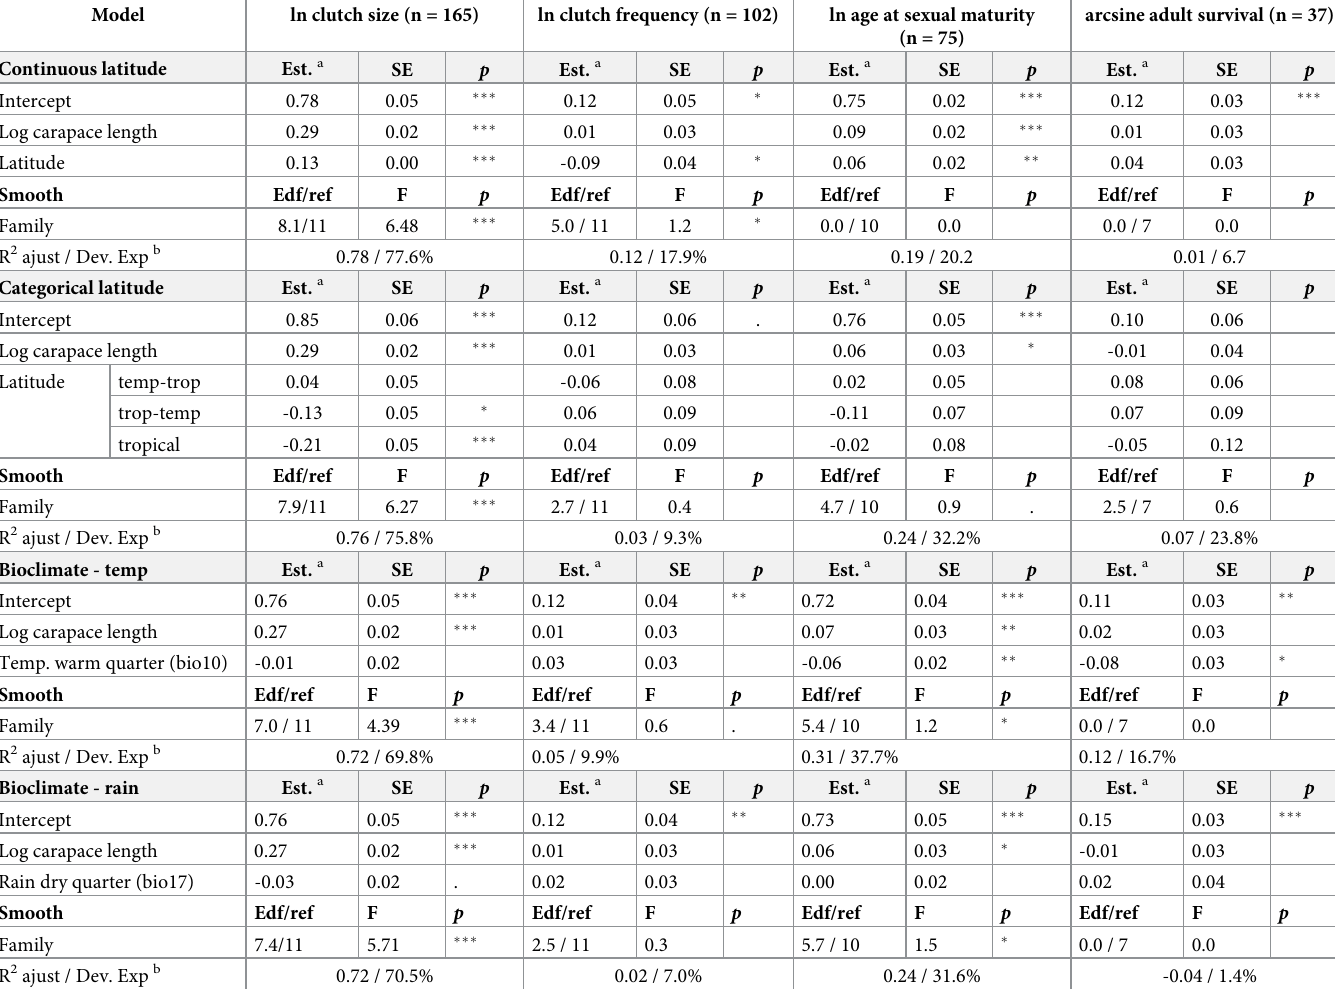
Table 2. Influence of climate variables and latitude on freshwater turtle life-history traits. Generalized Additive Models were used to predict responses of four fresh- water turtle life-history traits: clutch size, clutch frequency, age at sexual maturity and adult survival. Model